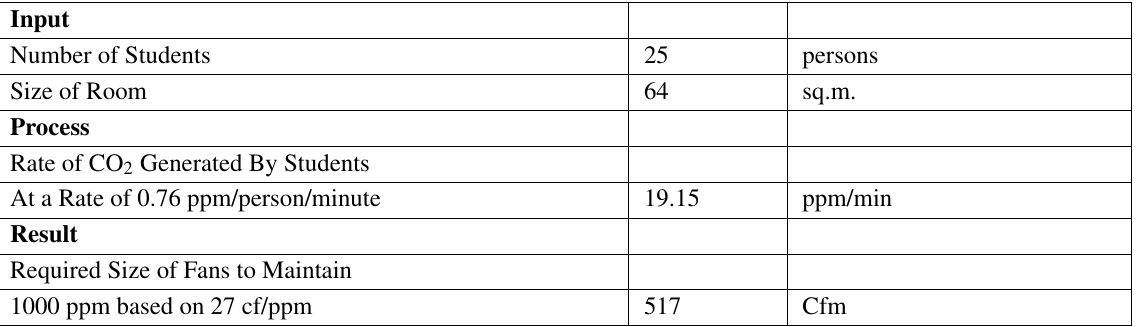
Table 1. Example in selecting the size of ventilation